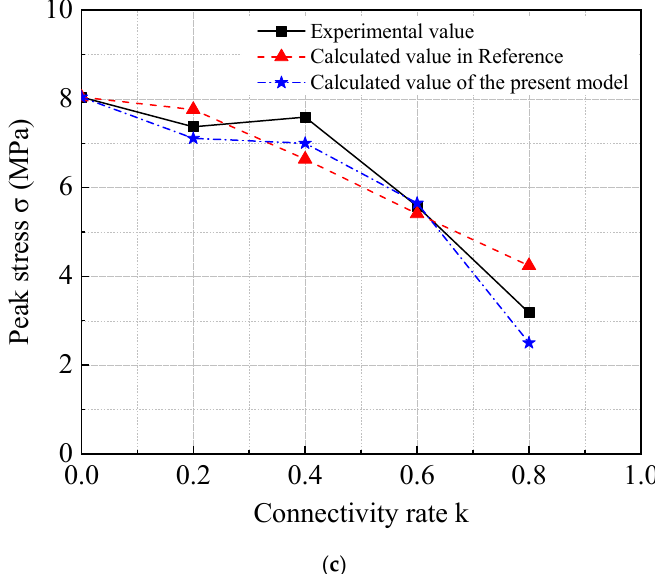
Figure 6. Curves of Peak Strength at Various Joint Inclination Angles. ( a ) α = 15°. ( b ) α = 45°. ( c ) α = 75°.